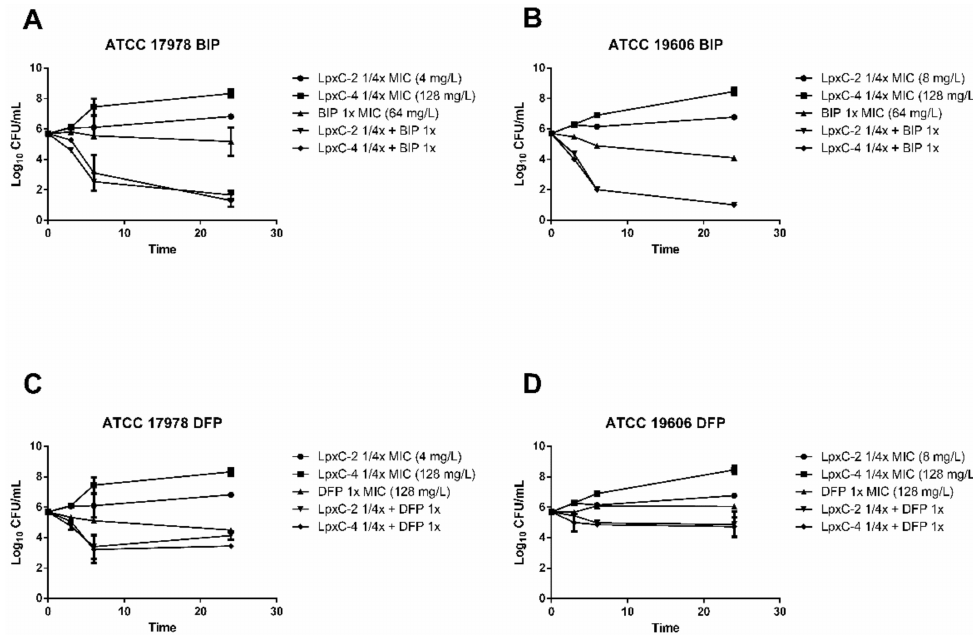
Figure 1. Time–kill curves for iron chelators in combination with LpxC inhibitors. Time–kill curves indicating bacterial counts in cultures at 0, 3, 6 and 24 h with the indicated A. baumannii strains containing combinations of BIP with LpxC-2 and LpxC-4 ( A , B ) or DFP with LpxC-2 and LpxC-4 ( C , D ). The indicated concentrations refer to the final concentration of each compound in the bacterial culture. BIP, 2,2 (cid:48) -bipyridyl; DFP, deferiprone. Time points indicate the mean bacterial count from a minimum of two biological replicates and error bars represent the standard